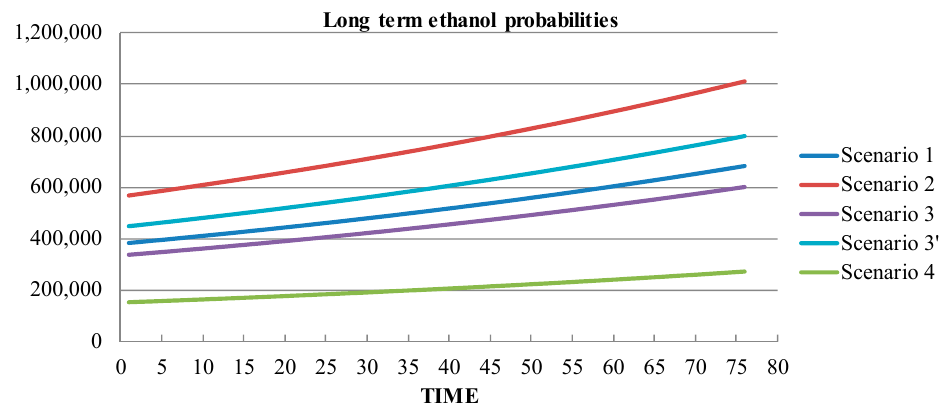
Figure 5. Long term ethanol probabilities in Michigan.